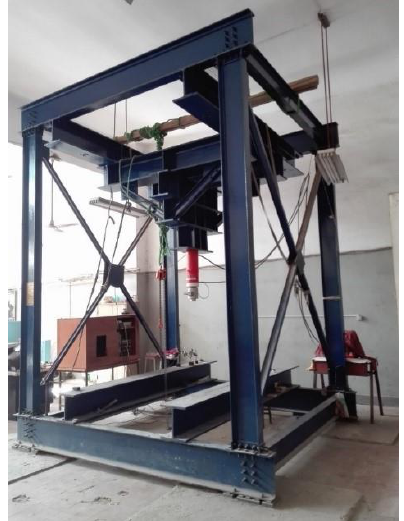
Figure 4. Rigid steel frame.